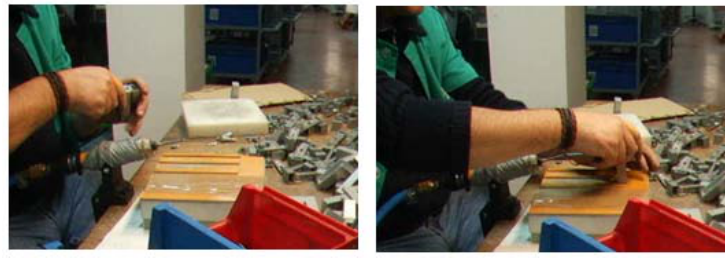
Figure 4. Successive motions of the worker using the Poka-Yoke designed in